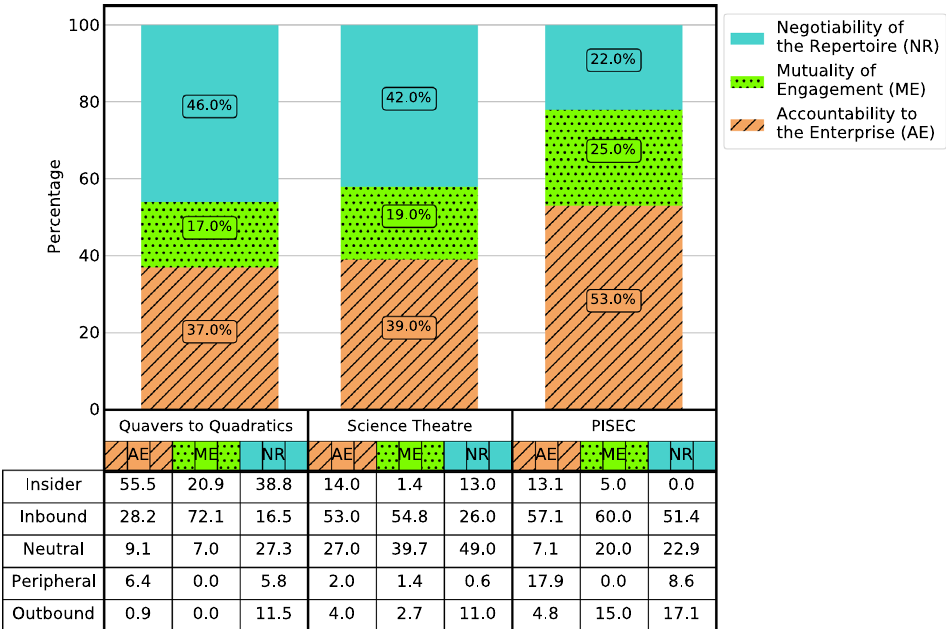
FIG. 2. The overall community dimension codes for each of the three informal programs (left to right: Quavers to Quadratics, Science Theatre, PISEC). The percentages shown in each bar indicate how many of the codes were assigned to each community dimension out of the total community dimensions codes per interview, and thus all the bars add up to 100%. The table shows the breakdown of each community dimension into the subcodes with the percentage indicating how often the subcode was assigned to a given community